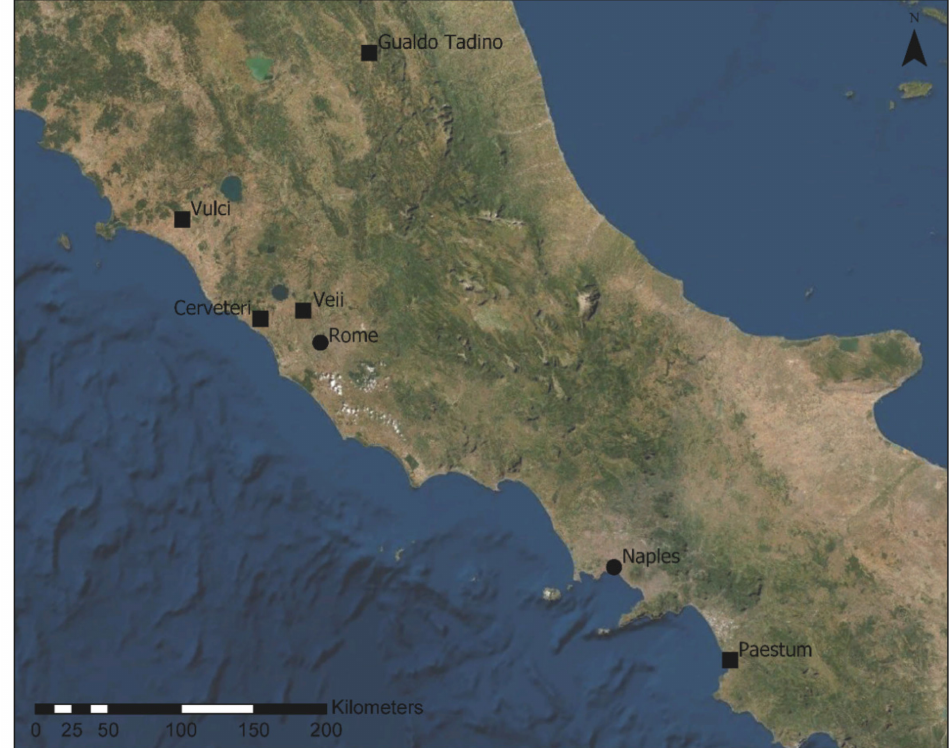
Figure 1. Location of the provenances where military equipment examined in this paper are from (Squares) and the location of Rome and Naples for reference